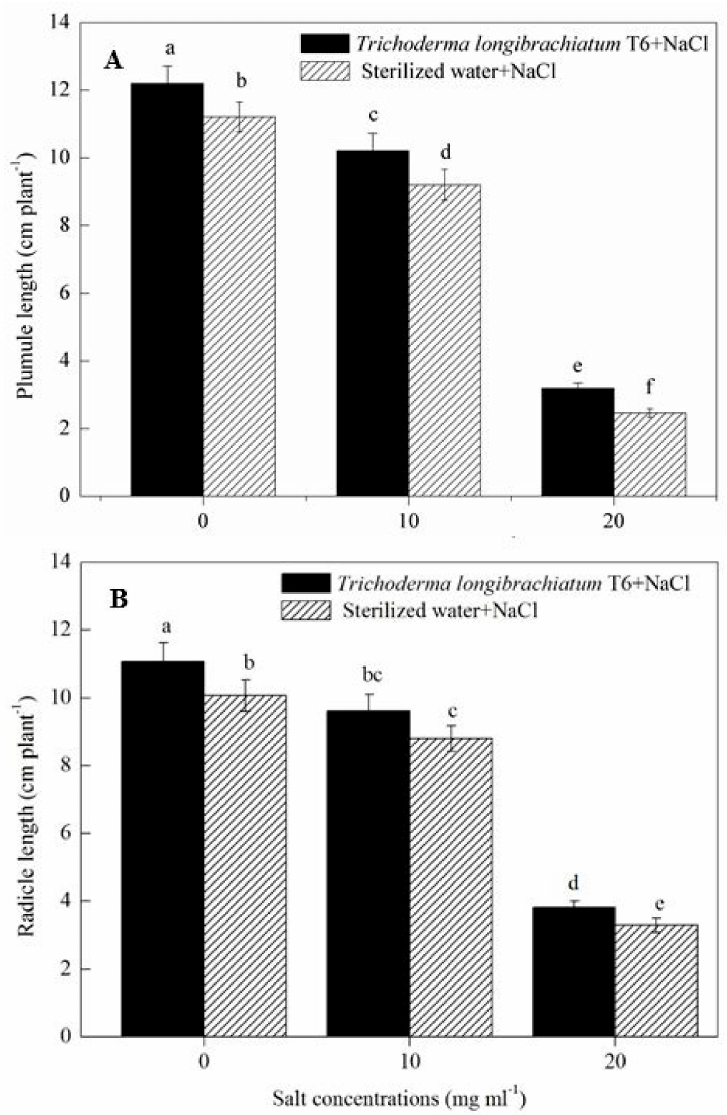
Figure 1. E ff ect of the strain Trichoderma longibrachiatum T6 on wheat seedling growth after treated with NaCl solutions, with ( A ) wheat seed plumule length and ( B ) radicle length. The line bars